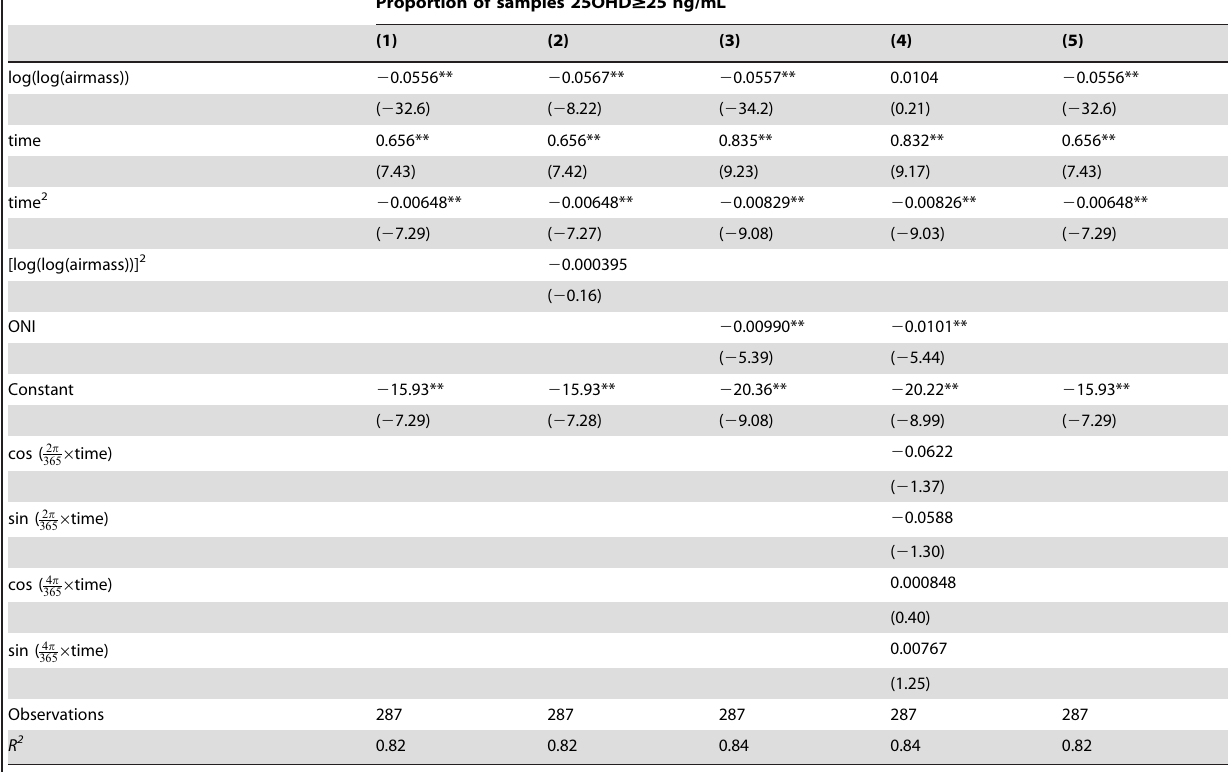
Table 1. Regression table; see text for complete